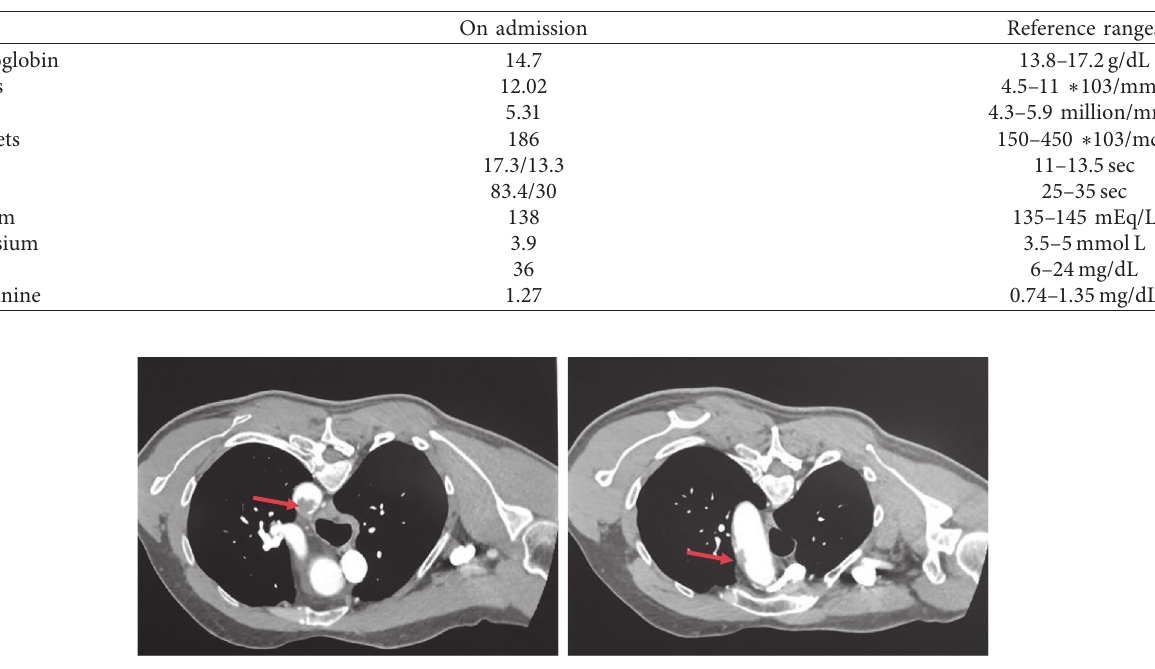
Figure 1: IV contrasted CT scan showing filling defect at the junction between the aortic arch and the descending aorta and an irregular mural thrombus with calcification in the aortic arch.